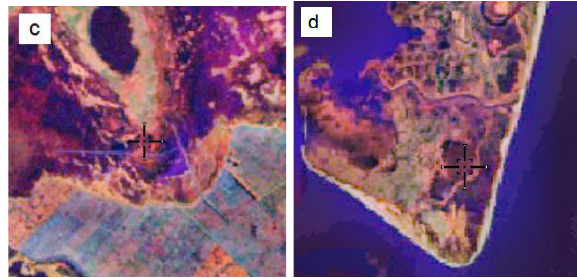
Figure 6a. Natural pasture or grassland formation; Figure 6b. annual culture; Figure 6c. humid grassland; Figure 6d. wetland.